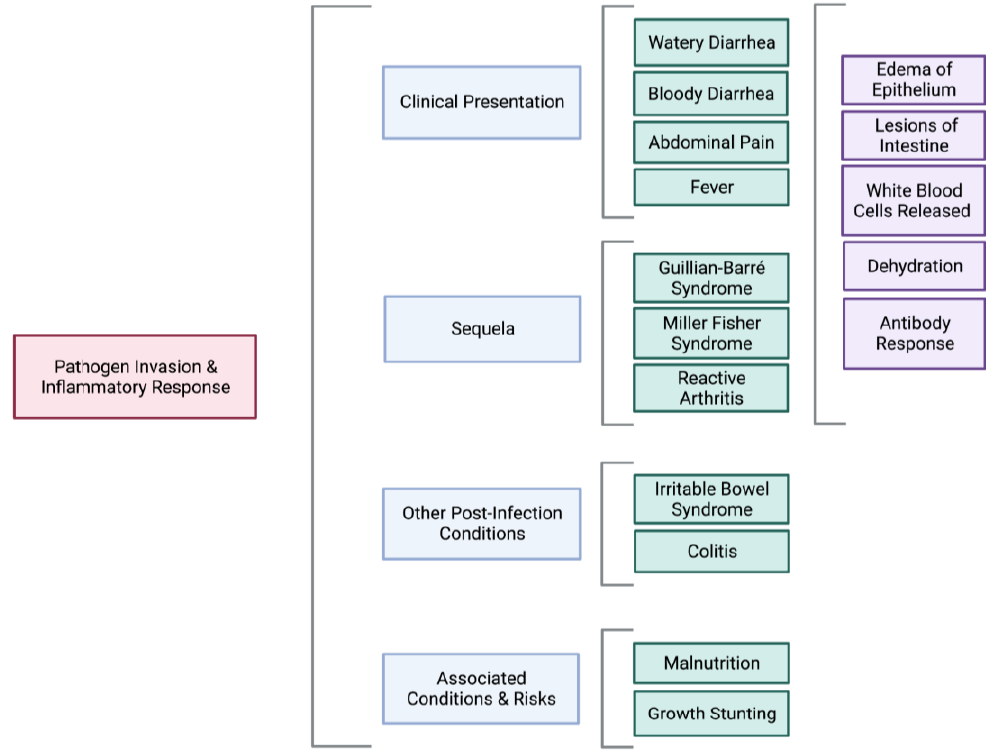
Figure 2. Clinical outcomes associated with C. jejuni infection. The primary clinical features of Campylobacter infection are diarrhea, abdominal pain, and transient fever. These symptoms develop from the pro-inflammatory response induced by pathogen invasion. Although rare, post-infection sequela such as Guillain-Barré syndrome (GBS), Miller-Fisher syndrome, and reactive arthritis may arise due induction of an antibody response. Other pre-existing conditions, such as irritable bowel syndrome (IBS) and colitis, might be exacerbated by C. jejuni infection. In low-resource setting countries, Campylobacter infection is correlated with malnutrition and growth stunting, though the underlying mechanism remains unclear.